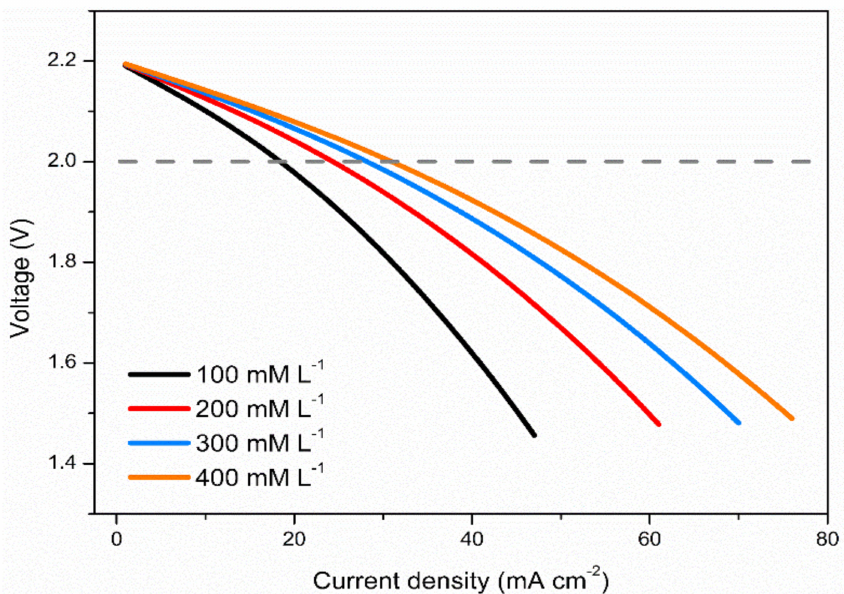
Figure 5. Effect of different initial vanadium concentrations. SOC: 50%; flow rate: 25 mL min − 1 ; temperature: 300